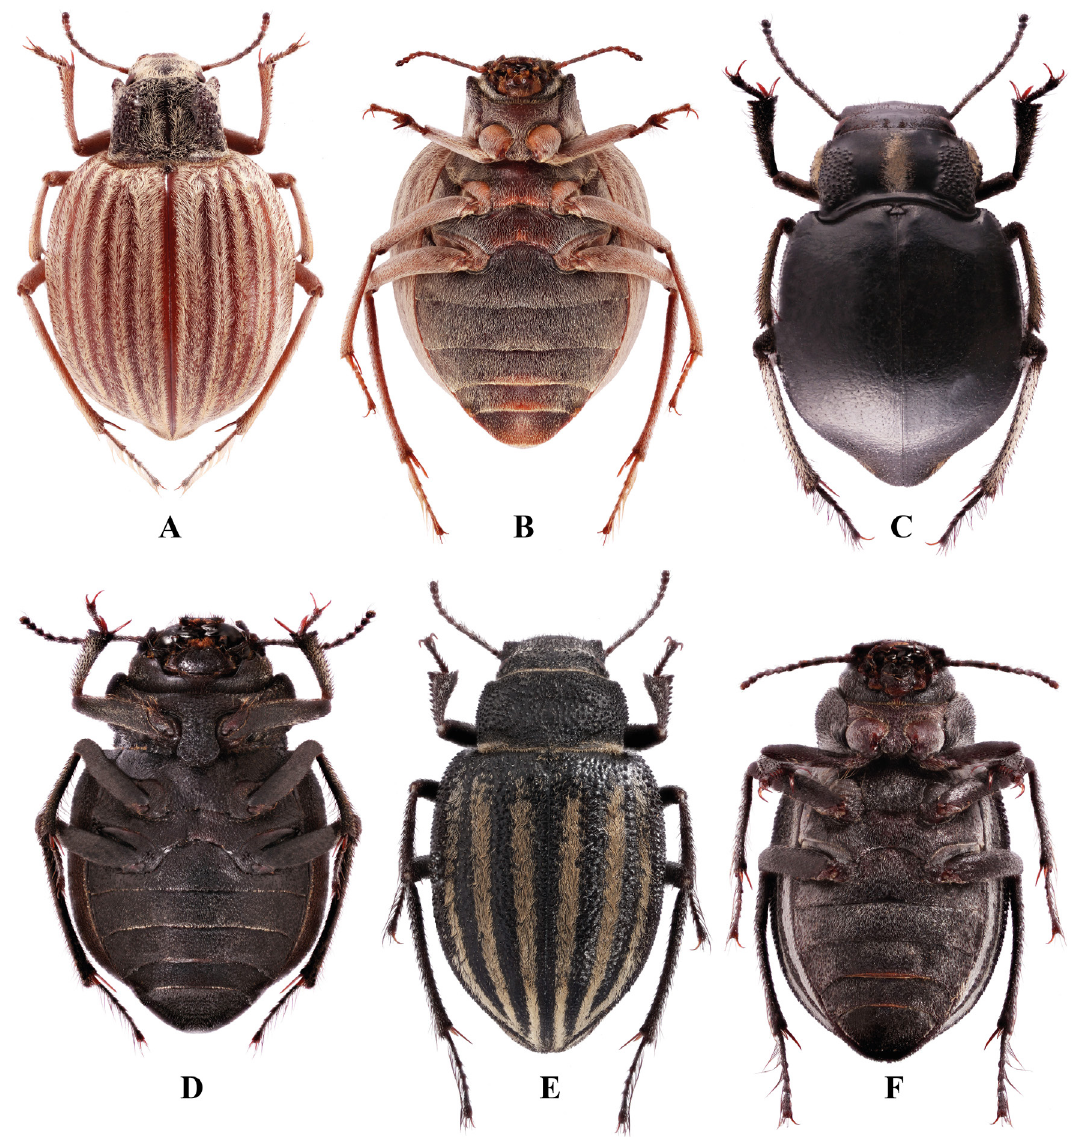
Fig. 4. Species of the genera Przewalskia Semenov, 1893, Mantichorula Reitter, 1889 and